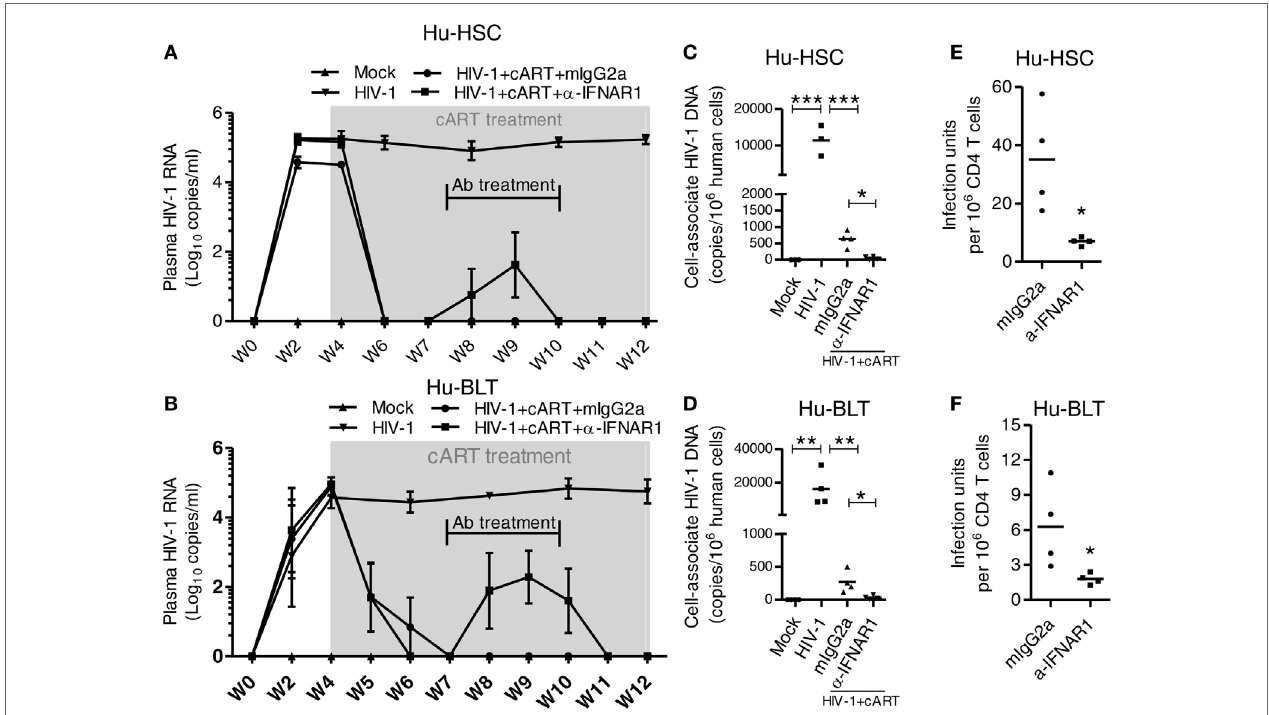
FigUre 9 | IFNAR blockade reduce HIV-1 reservoir in both HIV-1 infected NRG-hu HSC and NRG-hu Thy/HSC mice under combined antiretroviral therapy (cART). NRG-hu HSC and NRG-hu Thy/HSC mice infected with HIV-1 were treated with cART from 4 to 12 weeks postinfection (wpi). From 7 to 10 wpi, the cART-treated mice were injected with α -IFNAR1 antibody or isotype control mIgG2a antibody. (a,B) HIV-1 genomic RNA levels in the plasma of NRG-hu HSC (a) and NRG-hu Thy/HSC (B) mice. (c,D) Cell-associated HIV-1 DNA in human cells from spleen of NRG-hu HSC (c) and NRG-hu Thy/HSC (D) mice was quantified by PCR. (e,F) Replication-competent HIV-1 viruses from unfractionated human CD45 + cells from spleen of NRG-hu HSC (e) and NRG-hu Thy/HSC (F) mice were detected by the quantitative virus outgrowth assay. The frequency was determined by maximum likelihood statistics. The infectious units in CD4 T cells were calculated based on the percentage of CD4 T cells in total human CD45 + cells. Shown are representative data from n = 3 (NRG-hu HSC/Mock), n = 3 (NRG-hu HSC/HIV-1), n = 4 (NRG-hu HSC/HIV-1/cART/mIgG2a), n = 4 (NRG-hu HSC/HIV-1/cART/ α -IFNAR1), n = 4 (NRG-hu Thy/HSC/Mock), n = 4 (NRG-hu Thy/HSC/HIV-1), n = 4 (NRG-hu Thy/ HSC/HIV-1/cART/mIgG2a), n = 4 (NRG-hu Thy/HSC/HIV-1/cART/ α -IFNAR1) mice. Each dot represents one individual mouse; bars indicate mean (* P < 0.05, ** P < 0.01, and *** P < 0.001, by one-way analysis of variance and Bonferroni’s post hoc